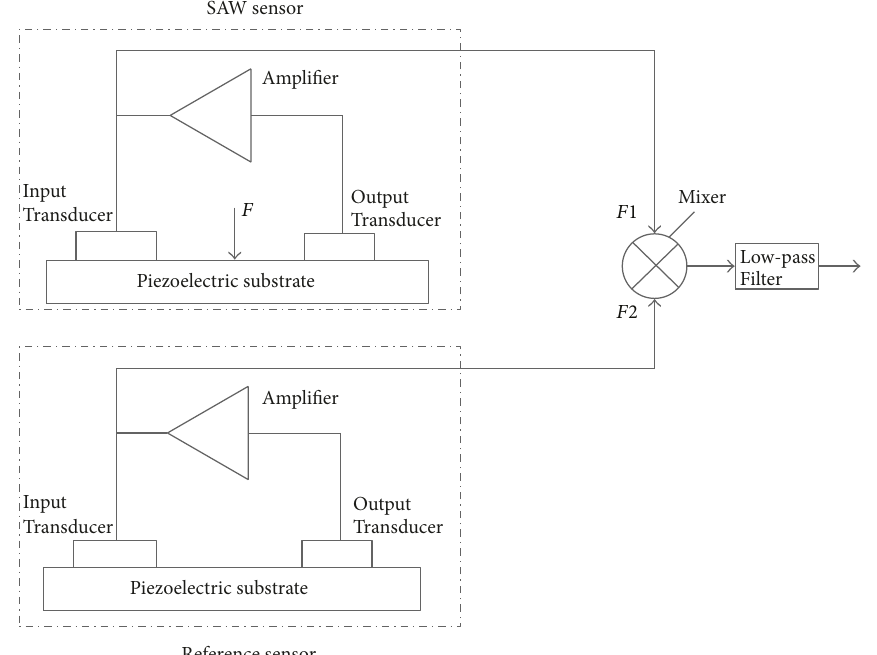
Figure 8: Principles of temperature compensation for SAW